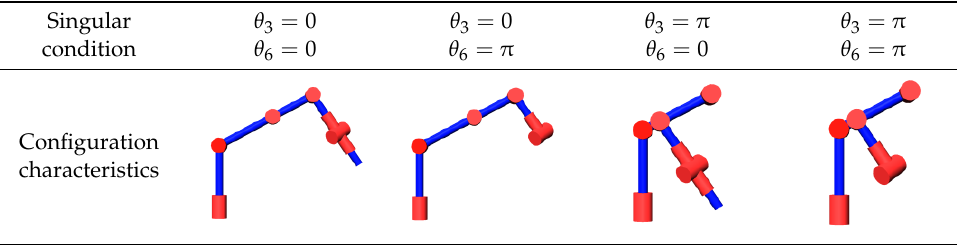
Table 4. Singularities corresponding to condition 2.